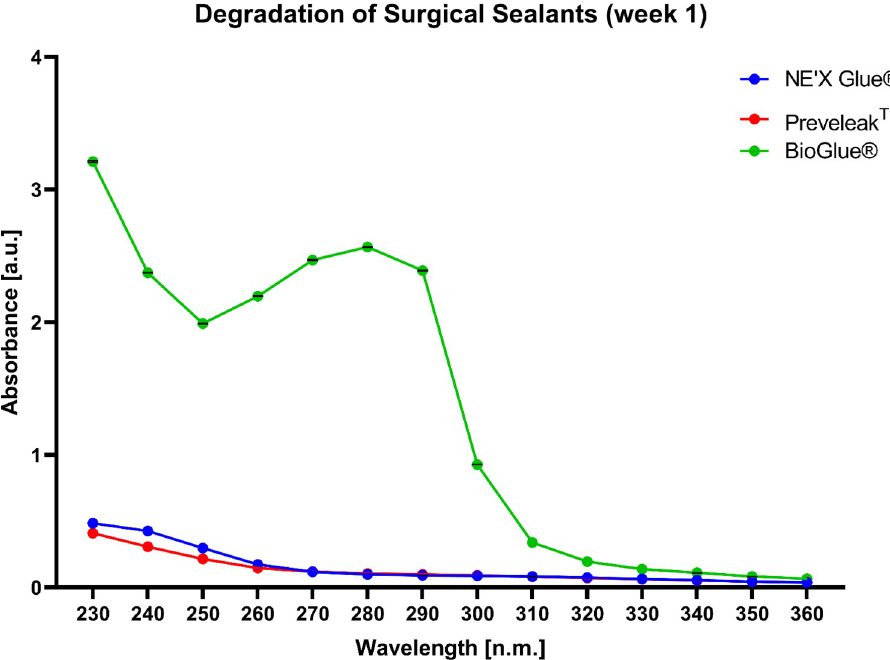
Fig 4. The degradation process of surgical sealants is illustrated as the absorbance spectra of water for injection after 1 week of incubation with the sample. n = 3 and p < 0.05 was considered statistically significant.